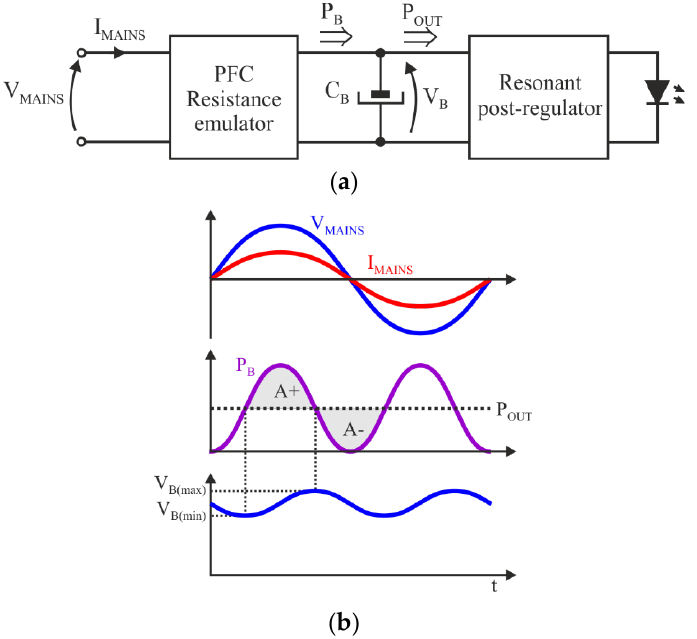
Figure 12. Input ripple estimation: ( a ) equivalent block diagram; ( b ) basic waveforms.